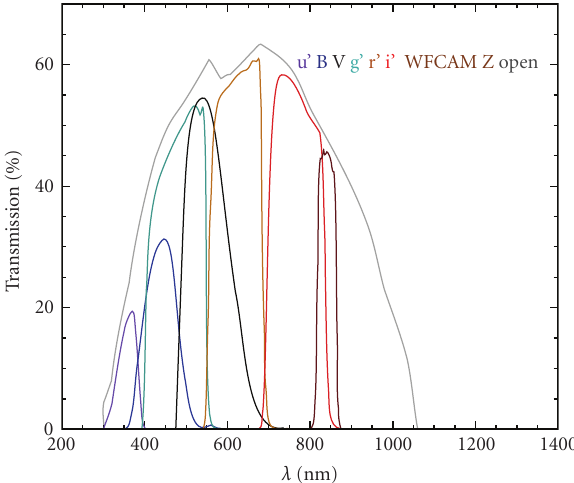
Figure 6: Approximate transmission curves for the filters imple- mented in our future 50 cm telescope. “Open” corresponds to no filters, and includes the e ff ects of atmospheric extinction, mirror reflectivity and CCD quantum e ffi ciency. The supernova search will be likely performed in “Open” mode or with a clear filter, but for the follow-up program we will use the filters shown here. It is possible that in the future we will include additional